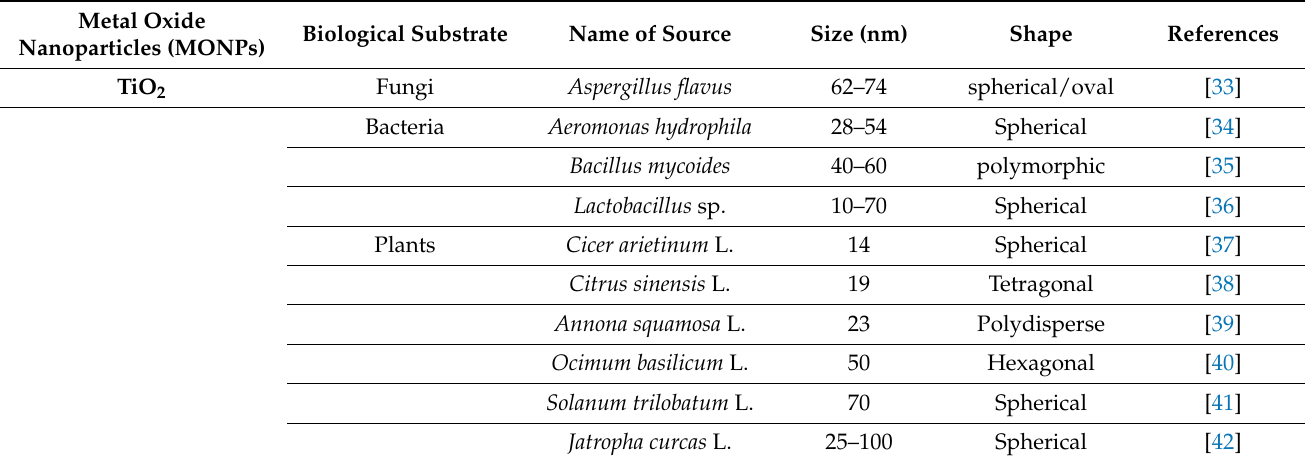
Table 1. Metal oxide nanoparticles (MONPs) synthesized from different biological substrates. Metal